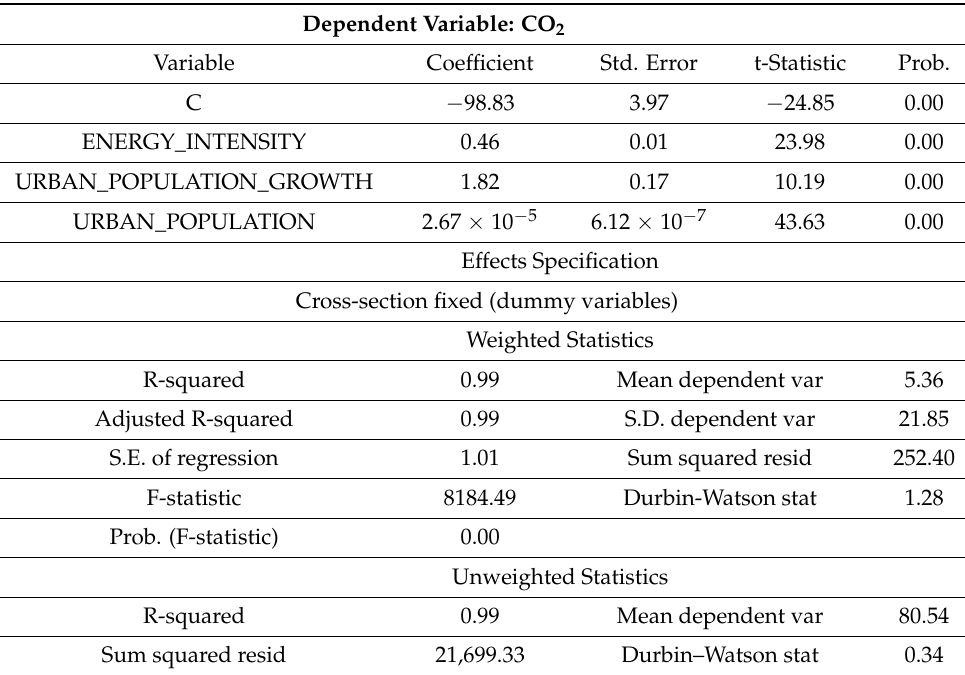
Table 6. Fixed Effect model using the Cross-Section SUR